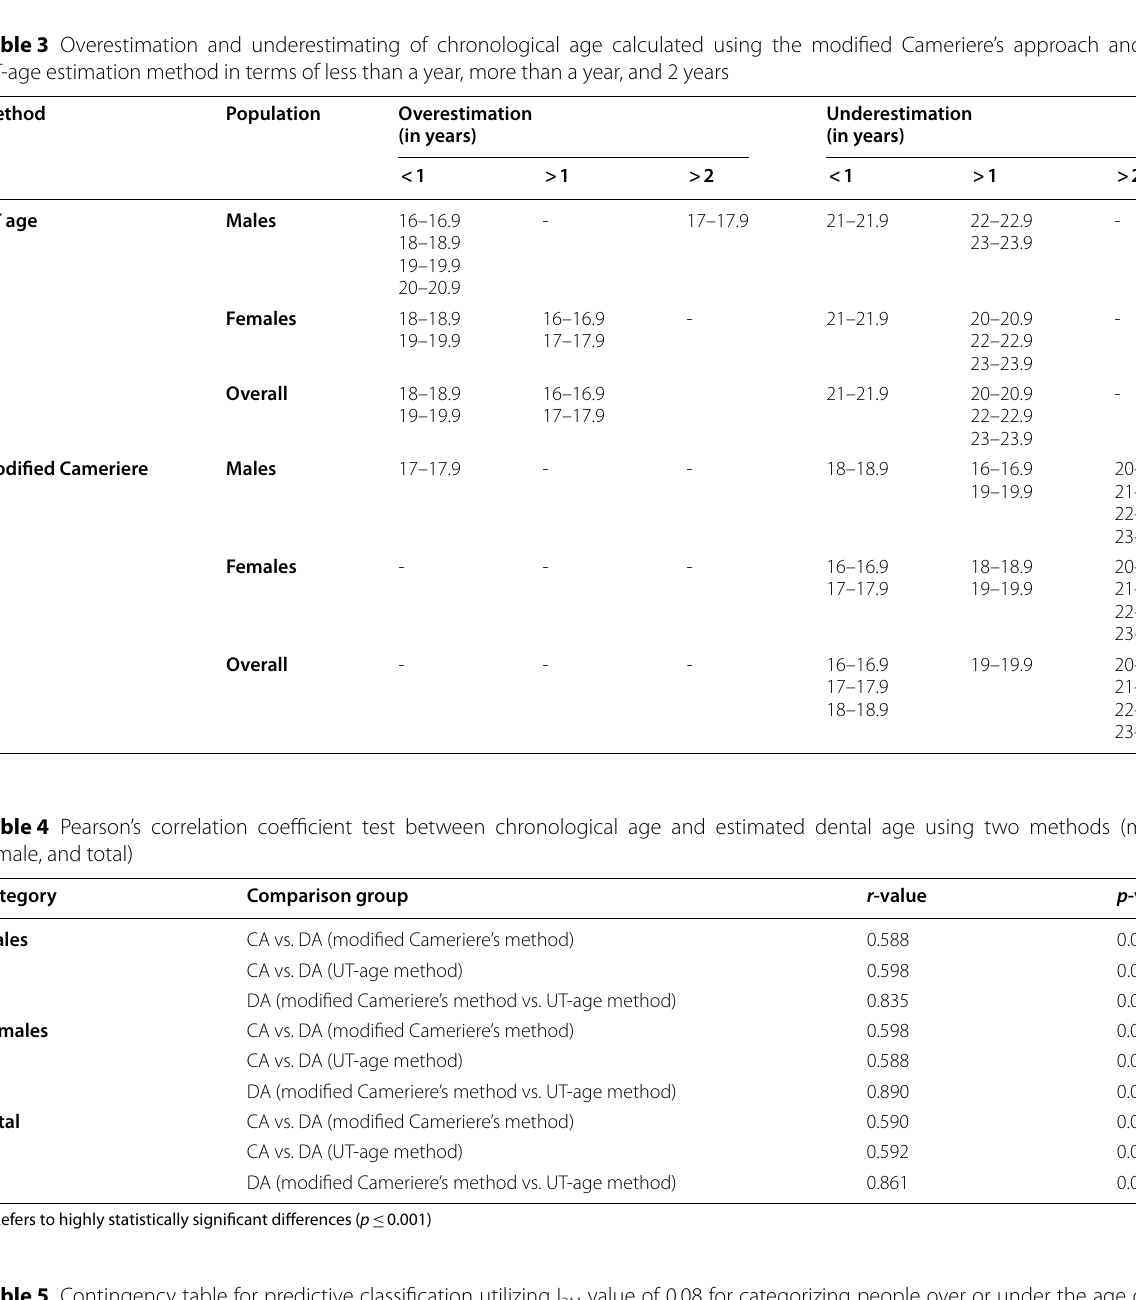
value of 0.08 for categorizing people over or under the age of 18. 3M